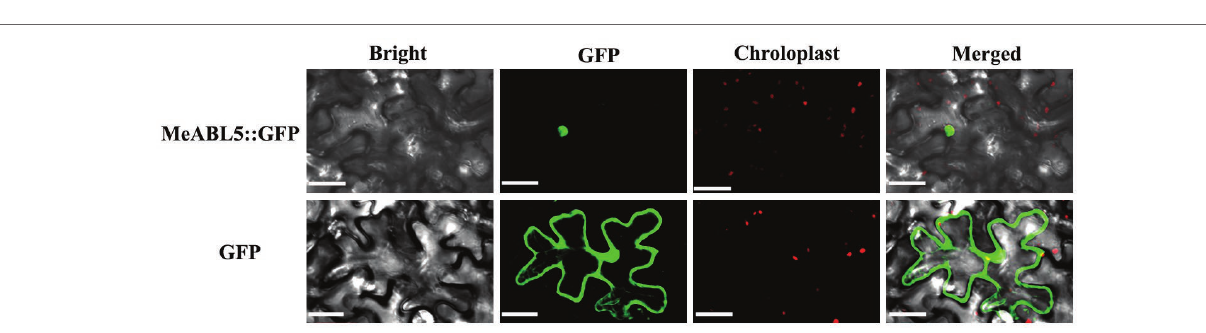
FIGURE 4 | Nuclear localization of the MeABL5 protein. Green fluorescent protein (GFP) fluorescence is shown in green and chlorophyll autofluorescence is shown in red as a chloroplast marker. Top row/bottom row: the corresponding bright field, GFP fluorescence, chlorophyll autofluorescence, and merged fluorescent images of MeABL5-GFP/GFP control. Bar = 30